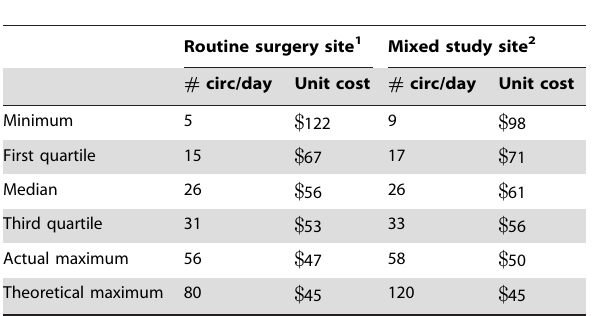
Table S1 Itemized consumables costs for forceps- guided routine surgical circumcisions. Table S2 Itemized consumables costs for PrePex-based circumcisions. Table S3 Durable equipment costs for the routine surgery site, mixed study site, and hypothetical mixed site.